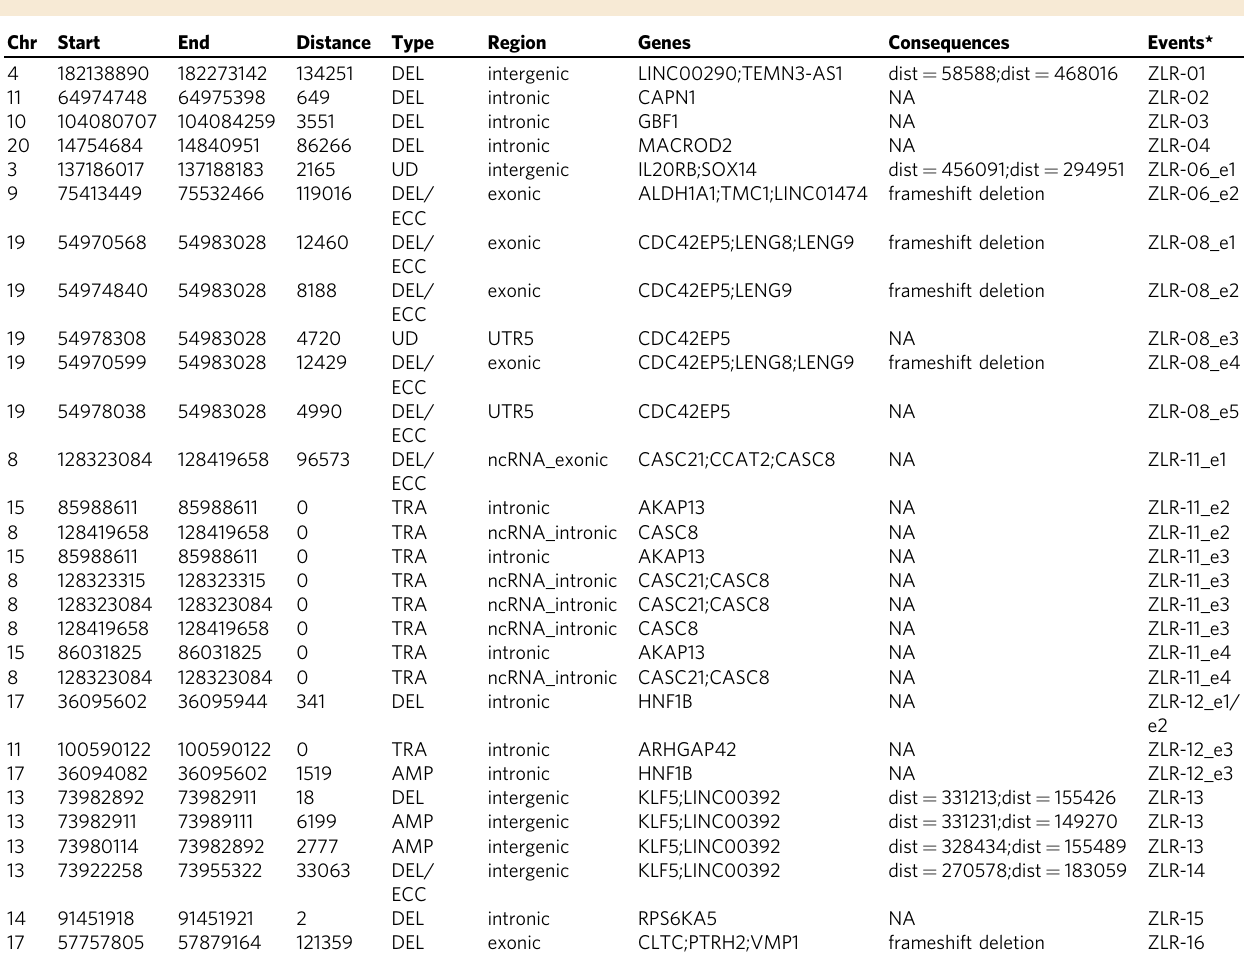
Table 2 Human genes potentially disrupted in HPV clonal integration events *